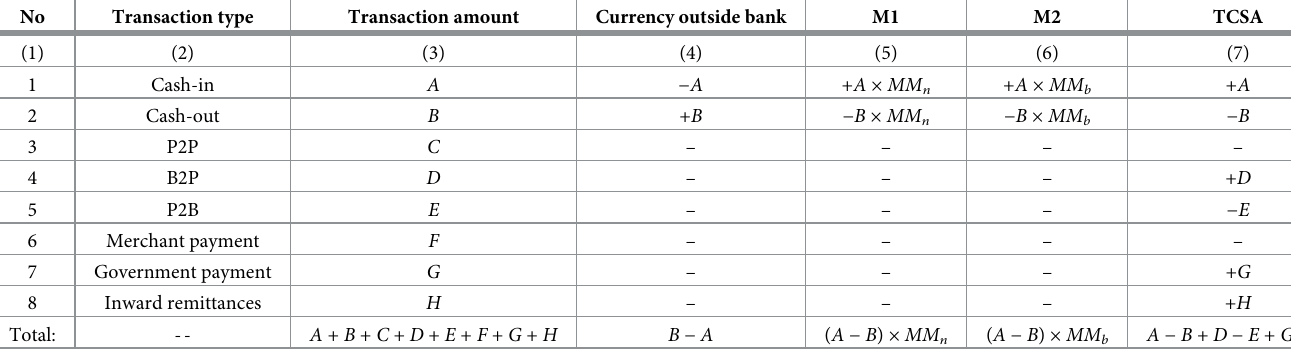
Table 2. Effect of MFS transactions on monetary aggregates during a given